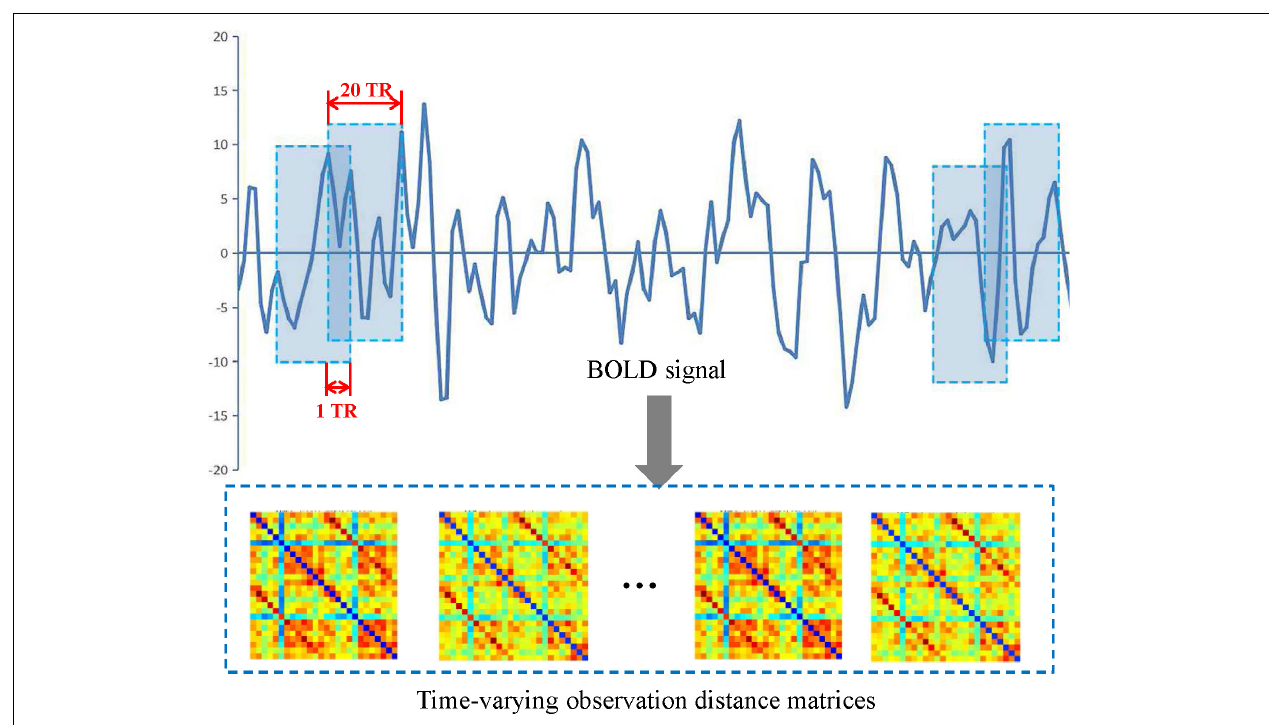
FIGURE 2 | Construction of a spatiotemporal brain network by the sliding window